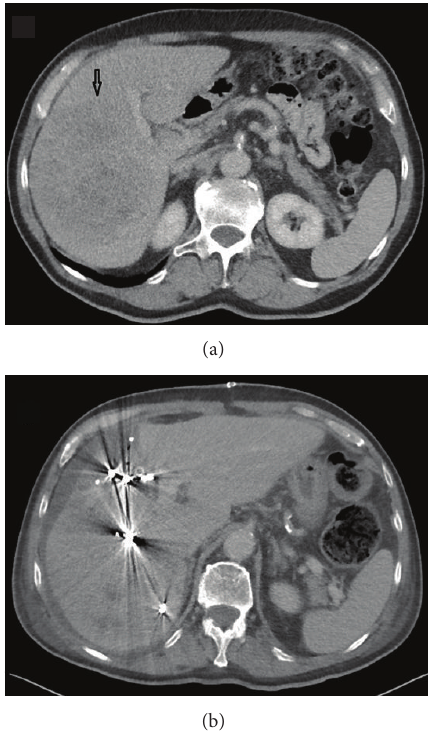
Figure 1: The liver in a patient with a large HCC on the right side before portal venous embolization (a) and the day after ISS (b). The arrow shows the tumor.